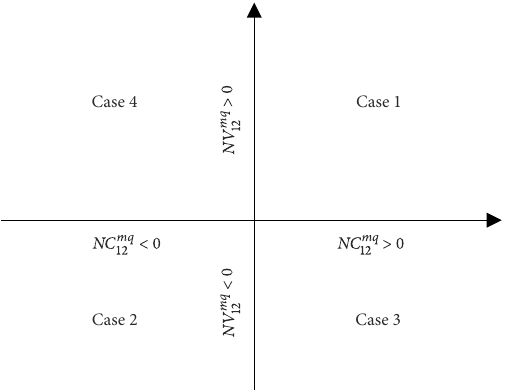
Figure 1. The classification of